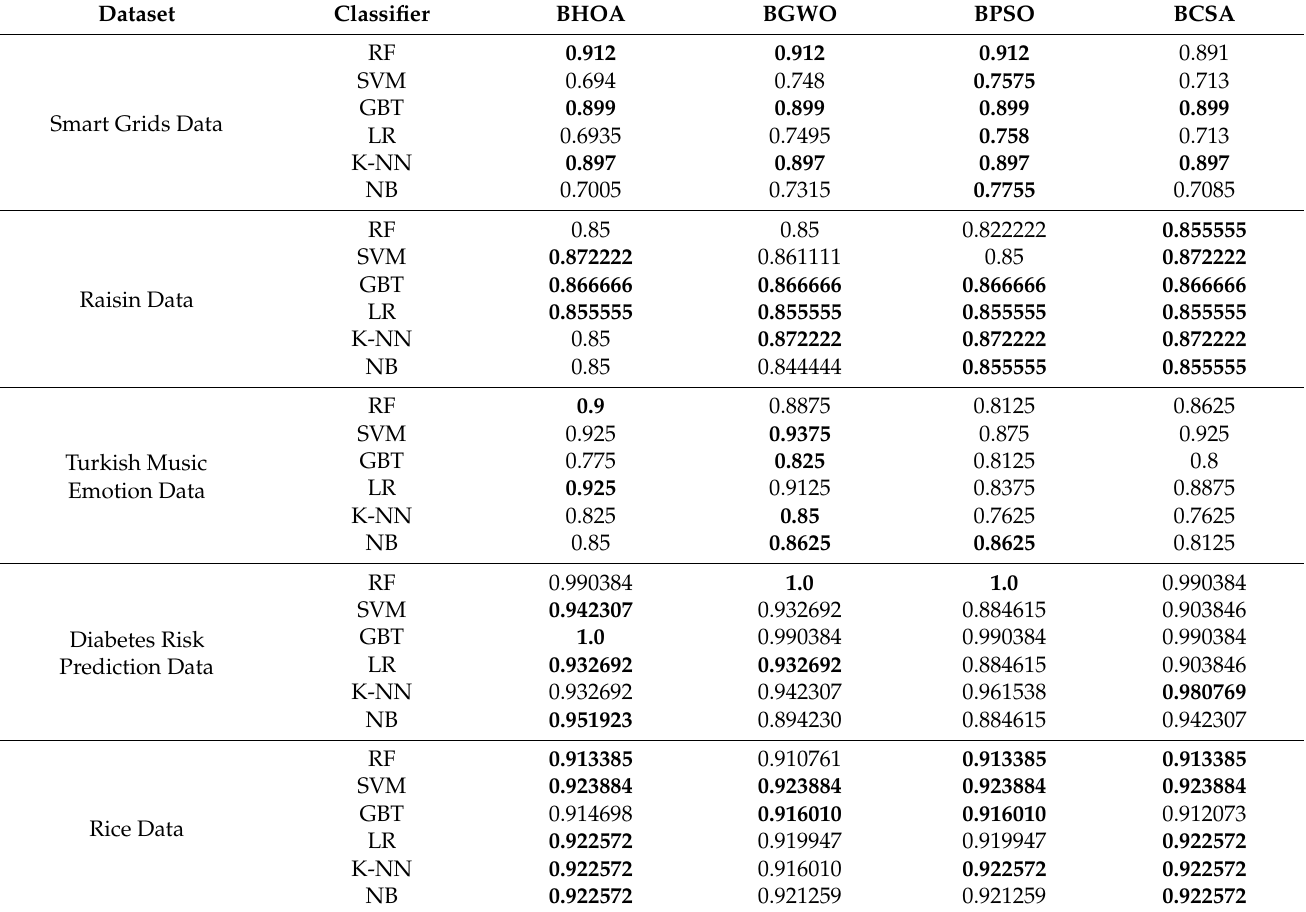
Table 15. Comparison of BHOA Accuracy Results to BGWO, BPSO, and BCSA Accuracy